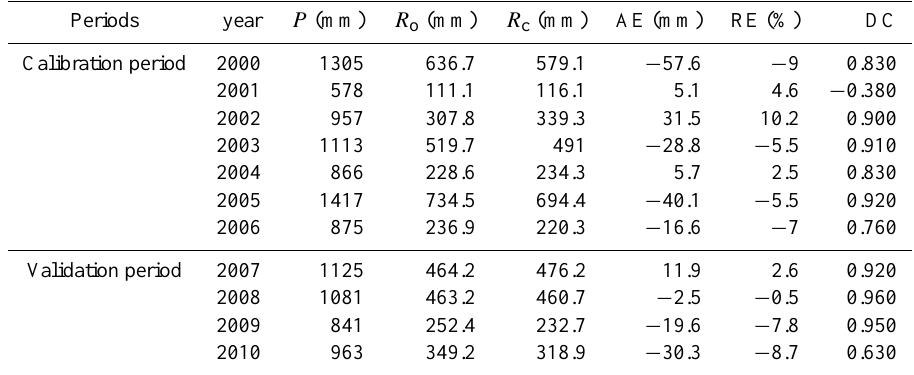
Table 3. Statistics of daily calibrated and validated results for Dapoling sub-basin in 2000s.